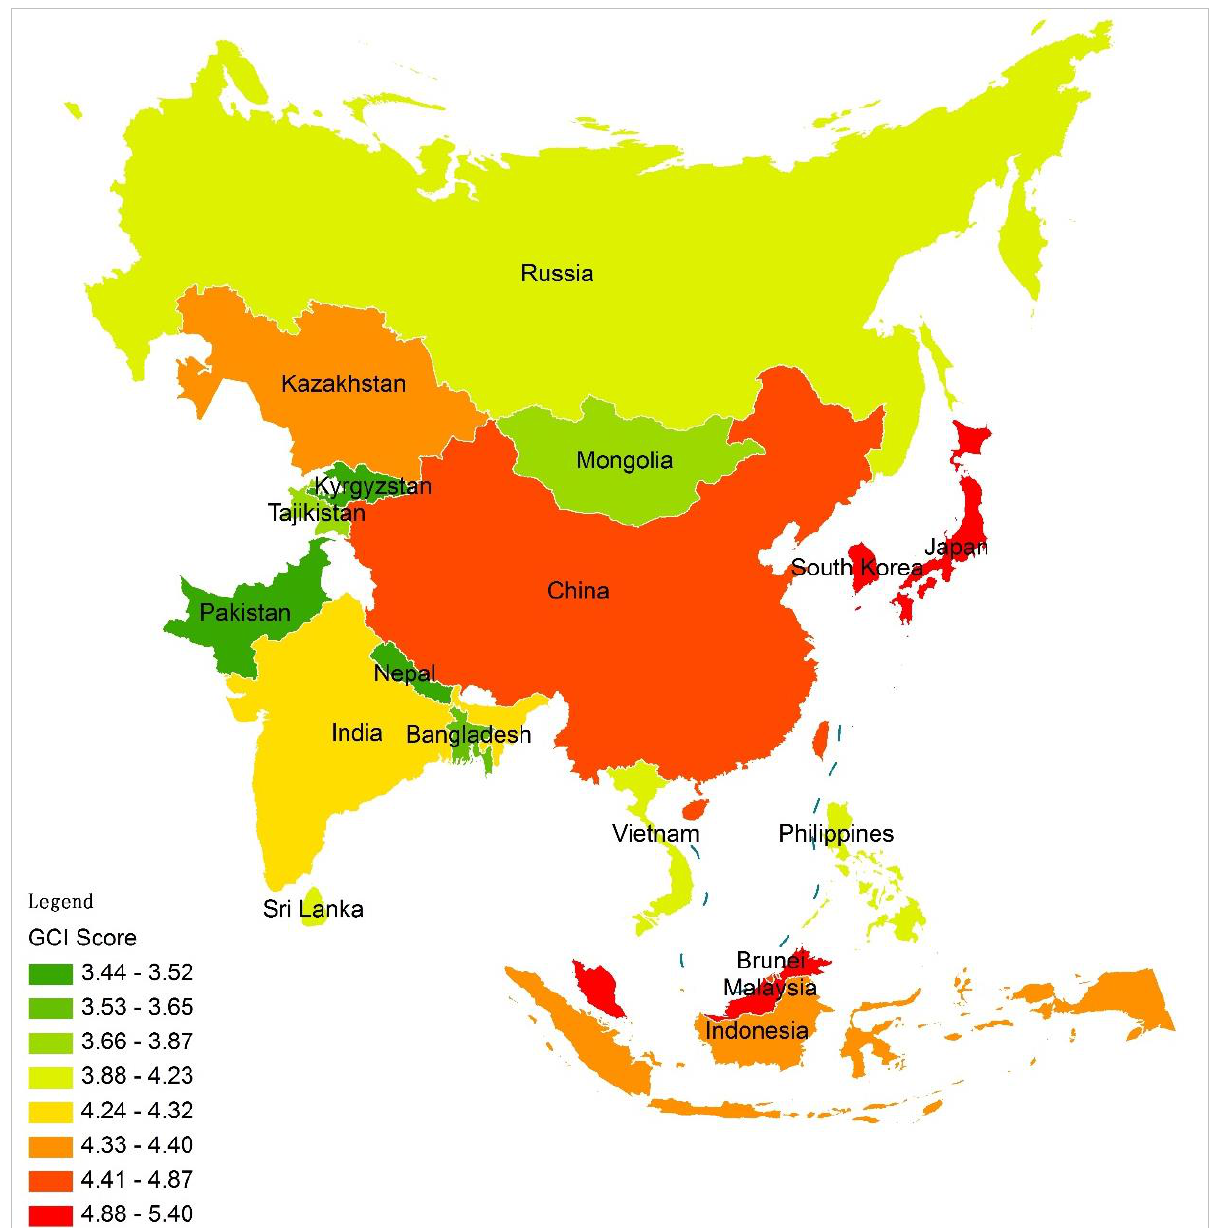
Figure 1. The GCI represented by the thematic map. Some countries (North Korea, Bhutan, and Burma) are not presented because of lacking